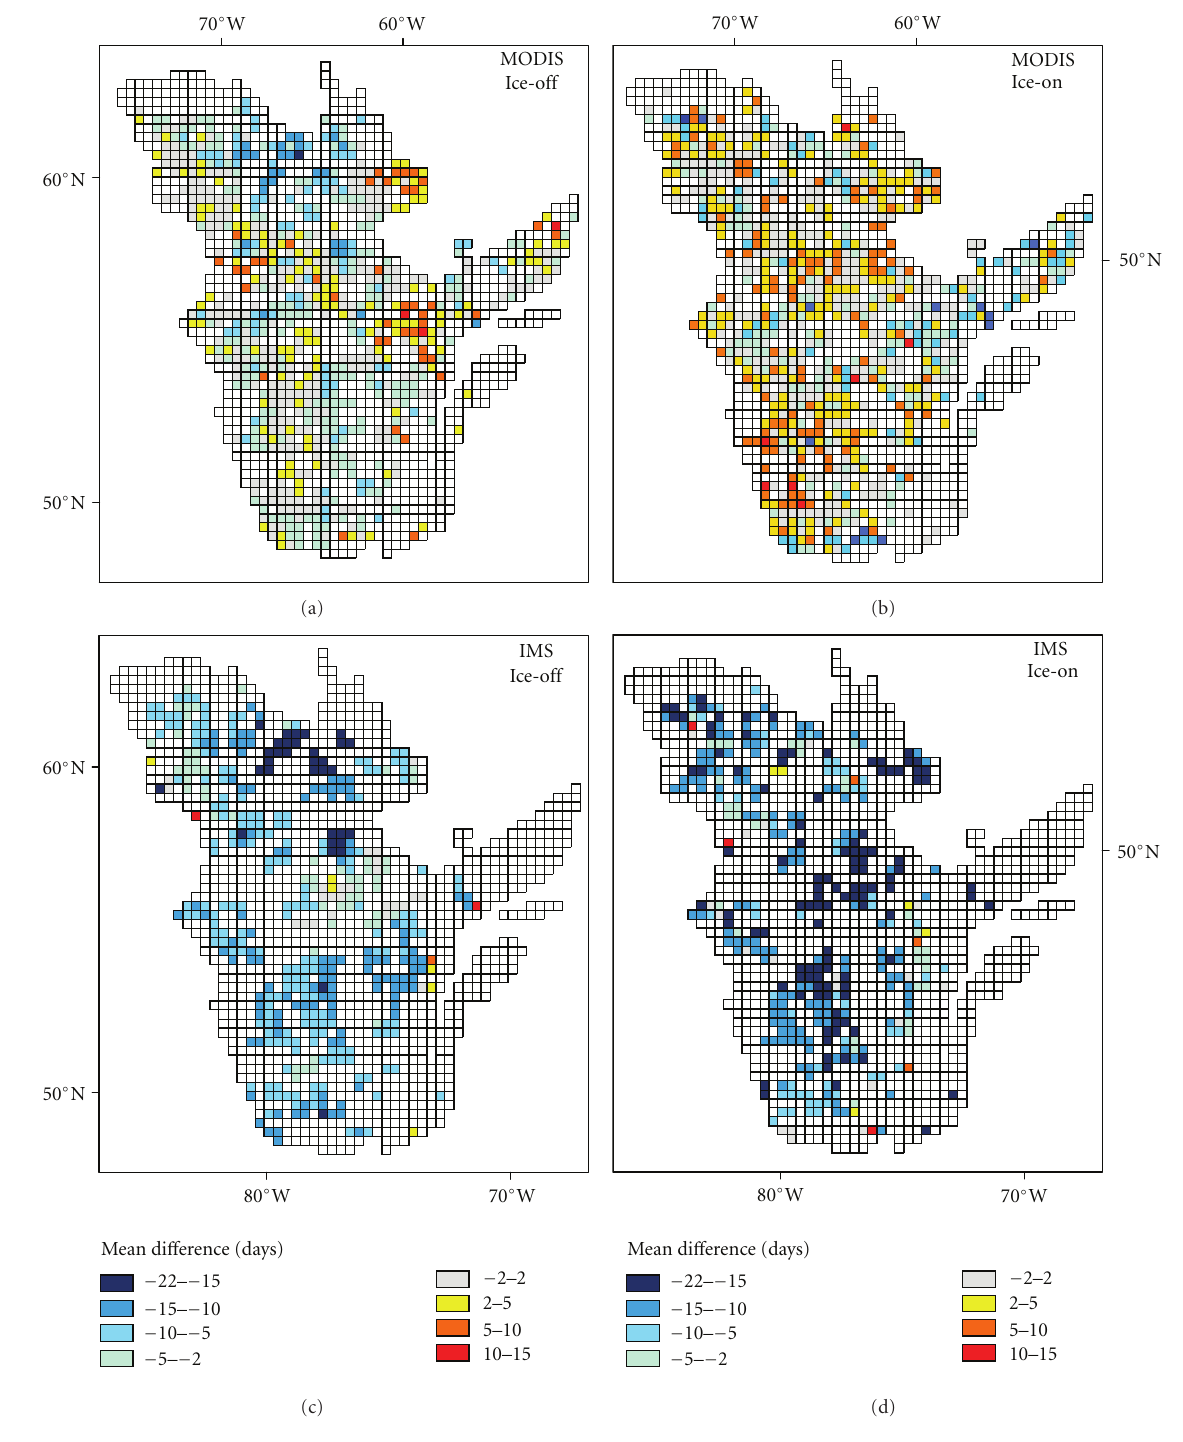
Figure 8: Mean di ff erence of simulated dates relative to satellite-detected dates for MODIS (11 years) and IMS (7 years) for each grid cell. Empty grid cells corresponded to areas where no lakes were identified using the stated